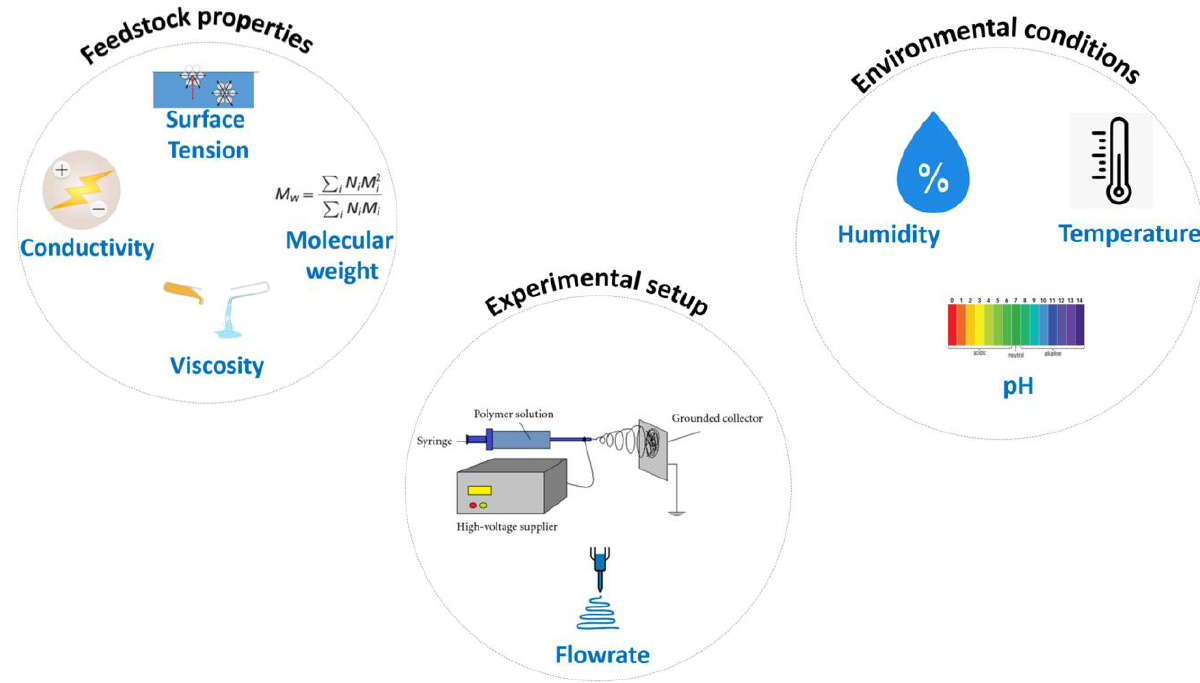
Figure 2. Factors affecting the Electrospinning process.